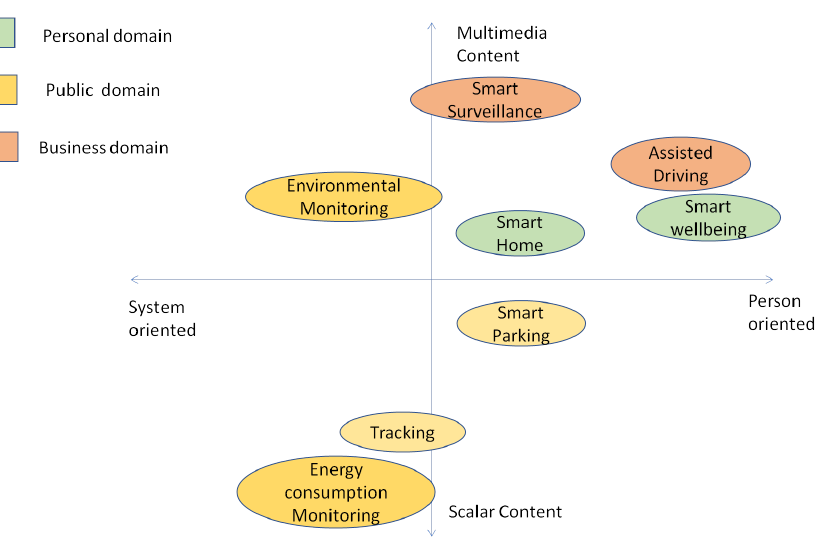
Figure 1. An IoT applications’ classification.